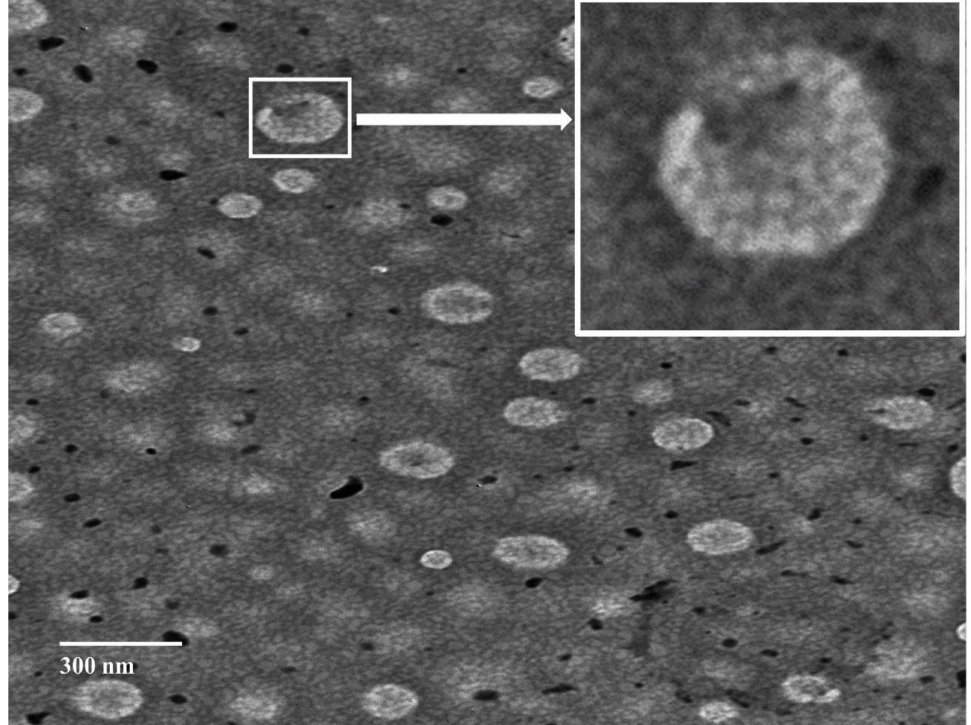
Figure 4. TEM morphology of the optimized formulation